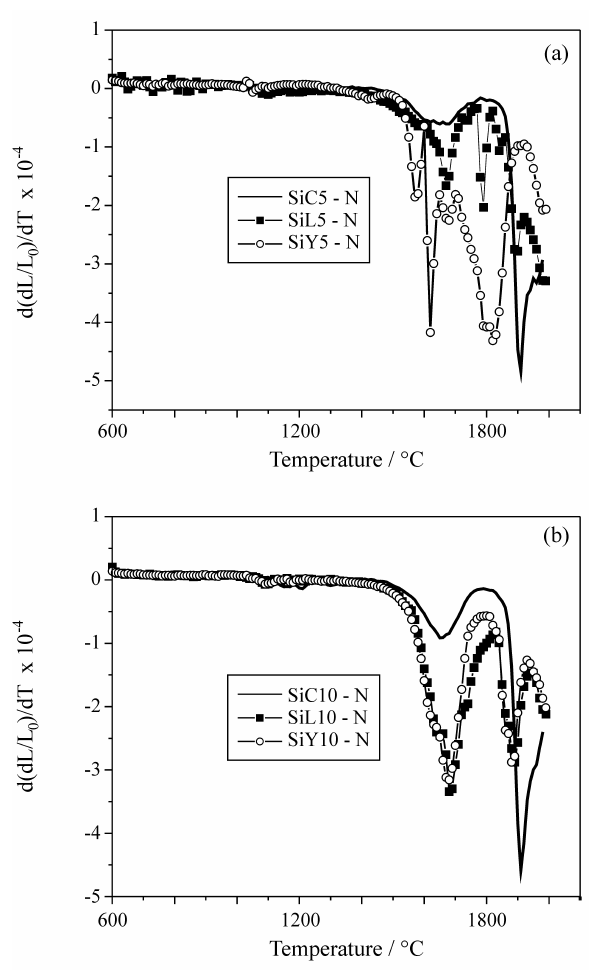
Figure 3. The results of dilatometric experiments: linear shrinkage vs. temperature while sintered in nitrogen: a) 5wt% α -SiC; b) 10wt% α -SiC.